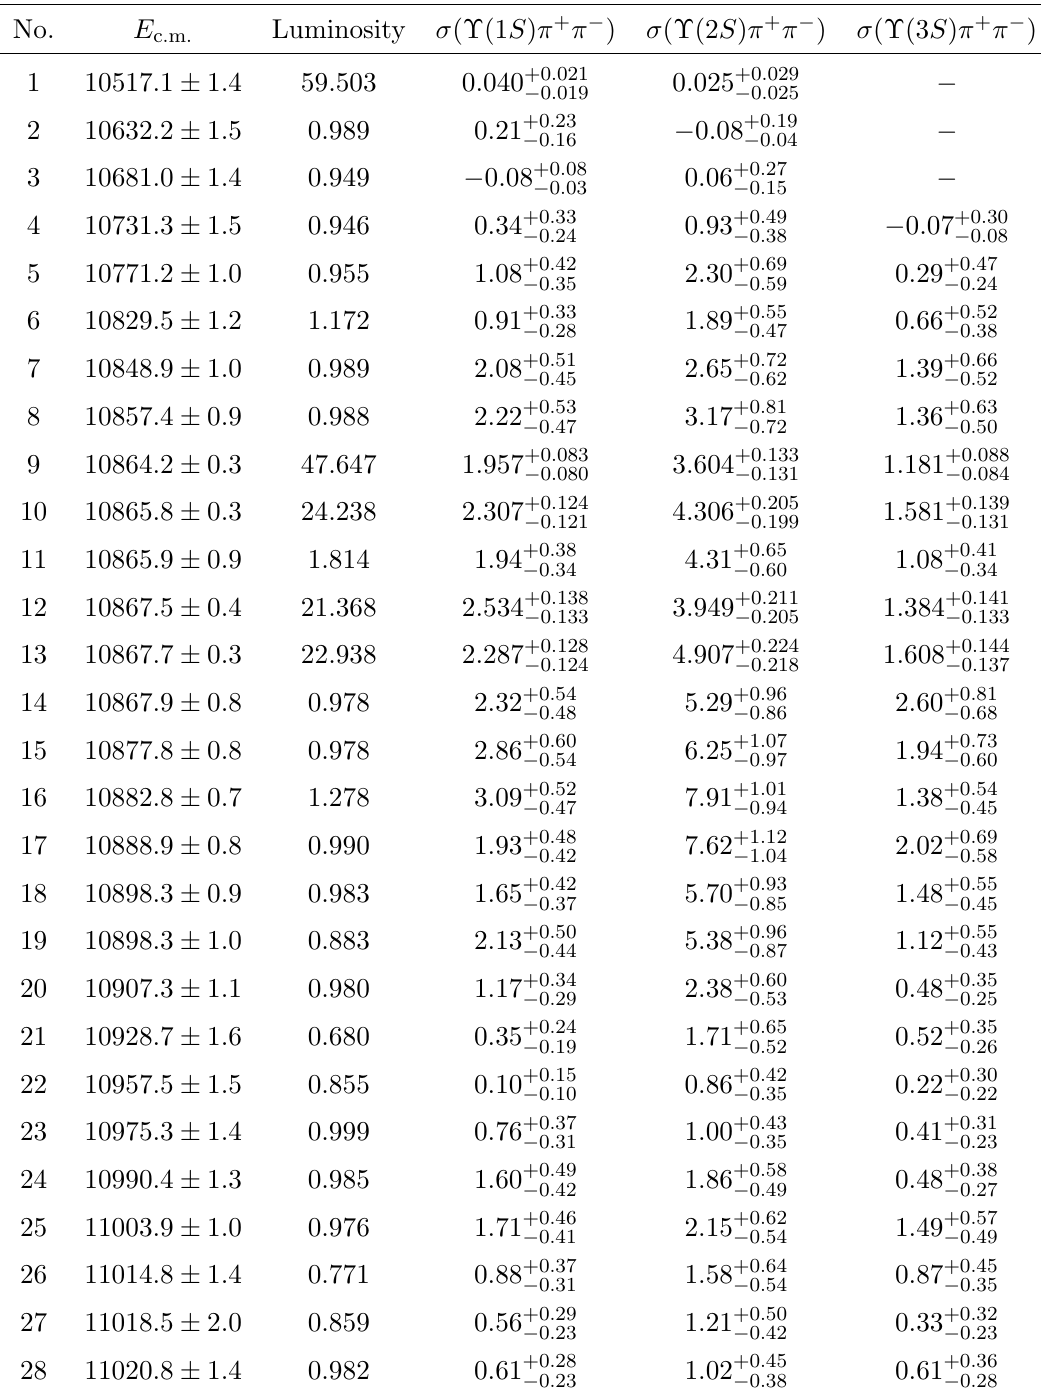
Table 1 . Calibrated c.m. energy (in GeV), luminosity of various data samples (in fb (cid:0) 1 ) and measured Born cross sections of the e + e (cid:0) ! (cid:7)( nS ) (cid:25) + (cid:25) (cid:0) ( n = 1 ; 2 ; 3) processes (in pb). The uncertainties in the energies and cross sections are totally uncorrelated.